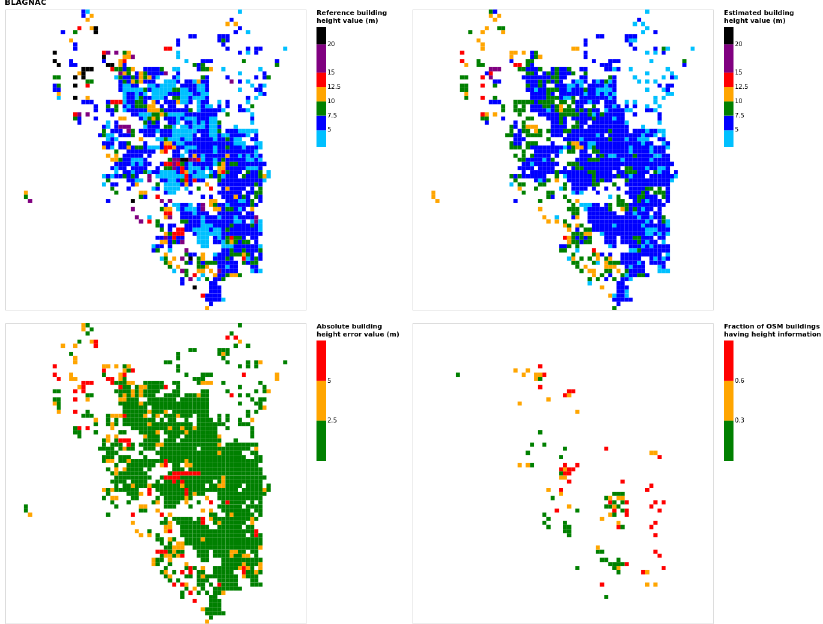
Figure B3. Results for the commune at grid cell (upper left panel) reference building height, (upper right panel) estimated building height, (lower left panel) absolute building height error, and (lower right panel) fraction of OSM buildings that have height information. For all panels except the lower right, only cells that have buildings – with at least 90% of their buildings having no height value in OSM – are displayed.